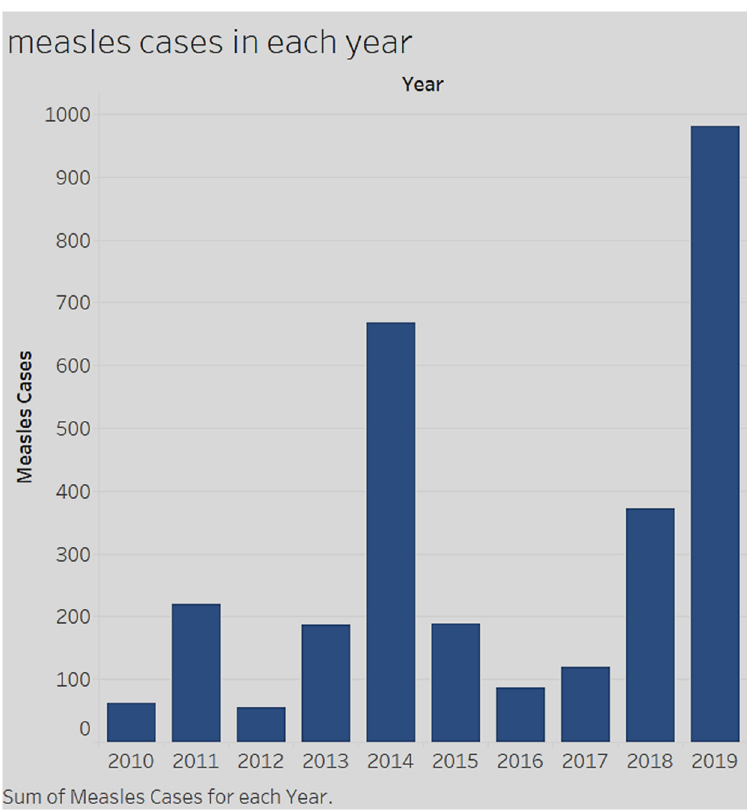
Figure 1. Measles cases in the United States (2010–2019) (https://www.cdc.gov/measles/cases- outbreaks.html).